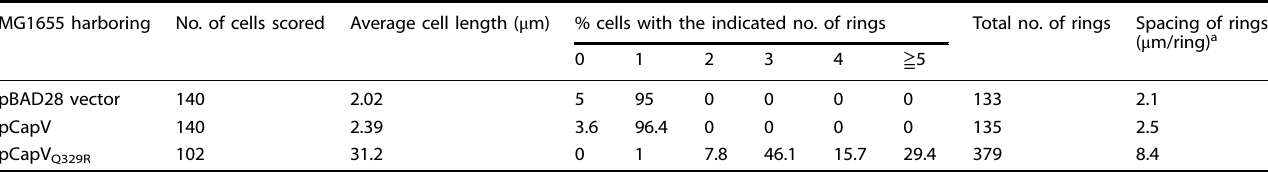
Table 1. Localization of FtsZ-GFP upon CapV Q329R overexpression. MG1655 harboring No. of cells scored Average cell length ( μ m) % cells with the indicated no. of